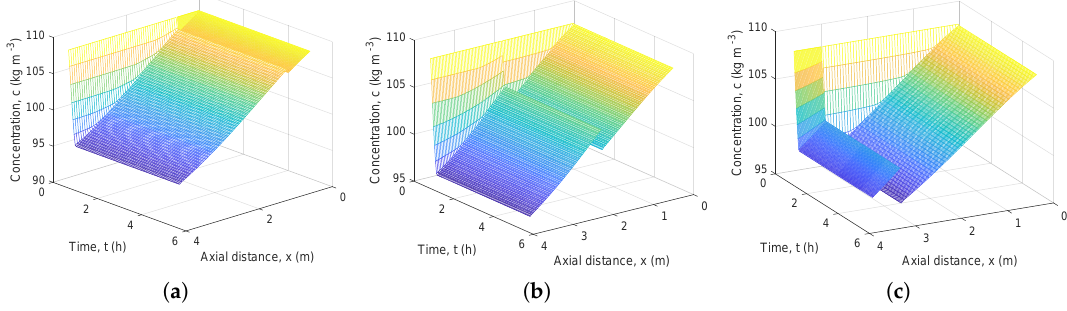
Figure 7. Evolution of liquid phase concentration of E 1 along the PFC1 for exchange locations—( a ) 1/6 × PFC length, ( b ) 1/2 × PFC length and ( c ) 5/6 × PFC length. The optimum location of exchange should be such that both the fresh feed concentration and exchange liquid concentration are best used. For this study, the location was 1/2 × PFC length. The sudden jump in concentration in the figures denotes the point where liquid phase exchange is carried